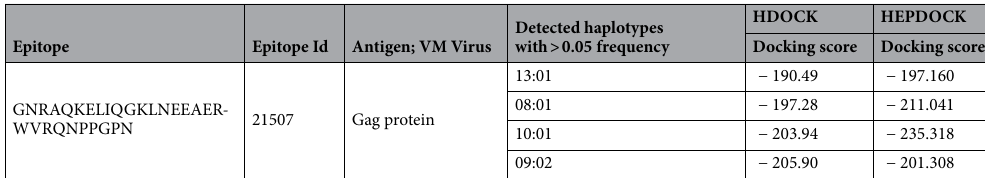
Table 3. Epitope-protein (DRB1) docking for VM virus Gag protein.